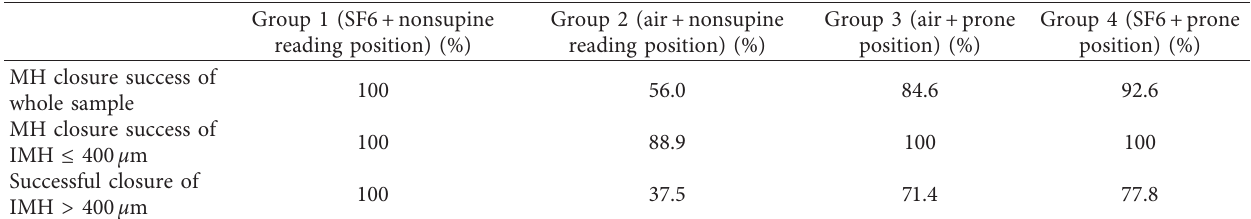
Table 2: Macular hole closure success rates after primary surgery in each individual